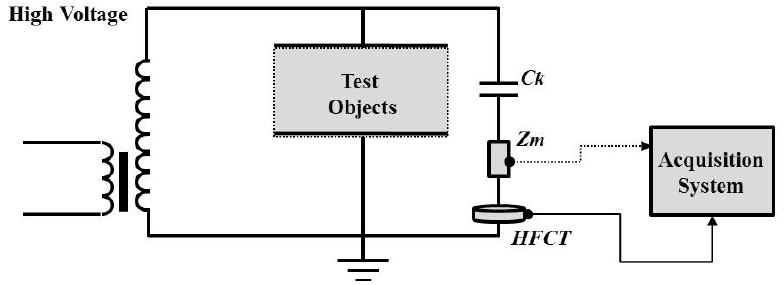
Figure 1. Experimental setup used according to the IEC 60270 standard.